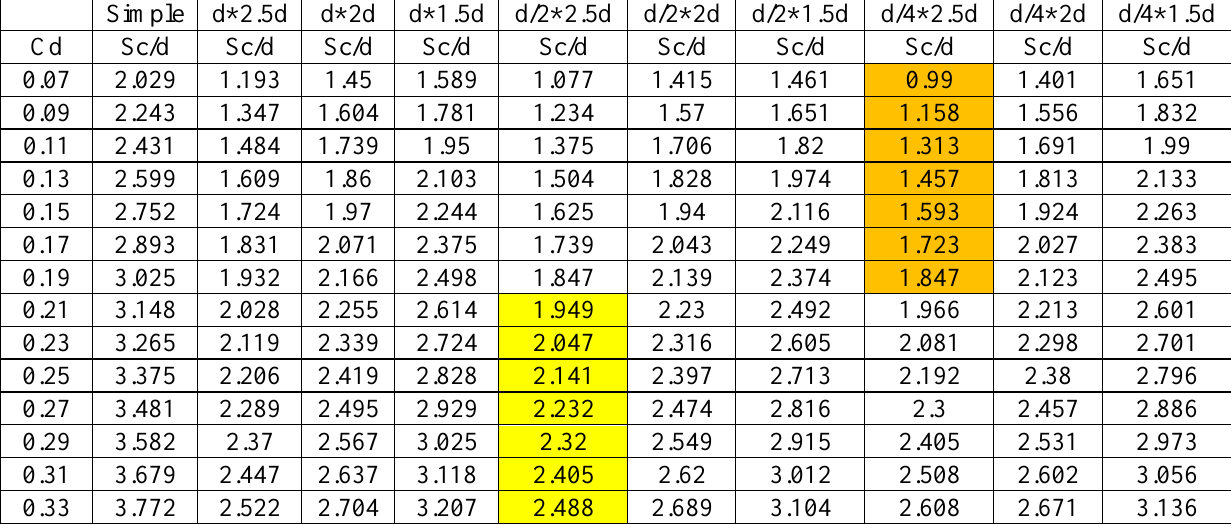
than the low discharge rates. This fact shows that using vertical meshed plates on the Table 3 Sc/d values for different anti-vortex plates at the same coefficients of the